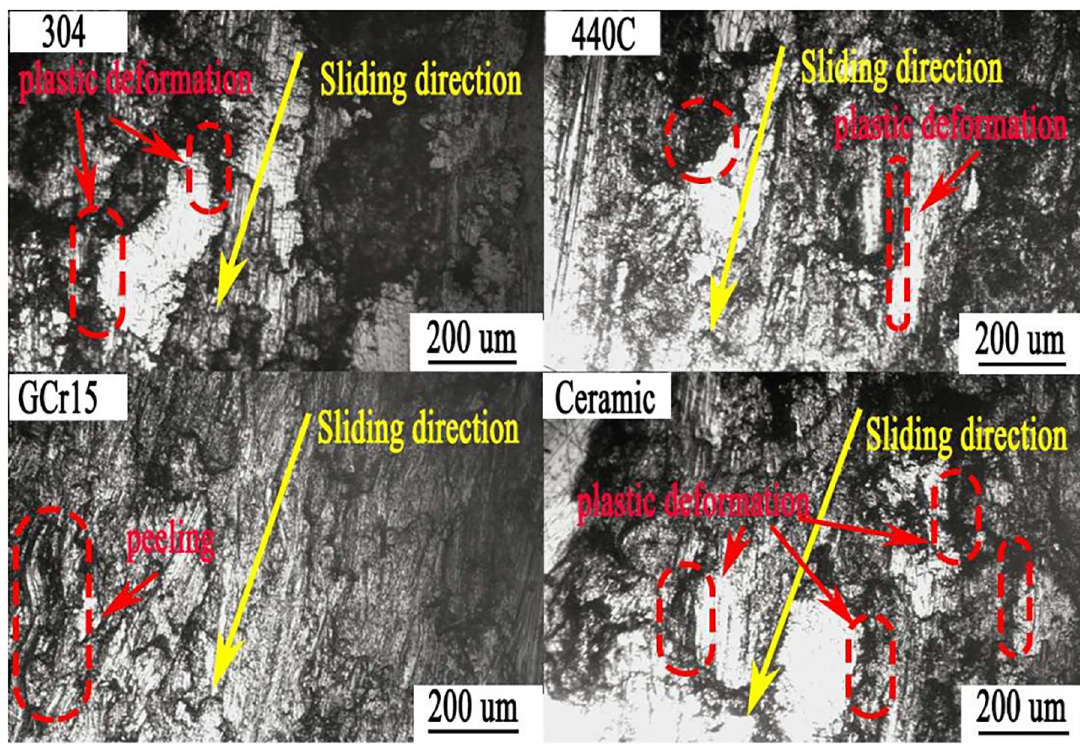
Figure 7. Worn morphologies for 9Cr18Mo with different secondary frictional pairs